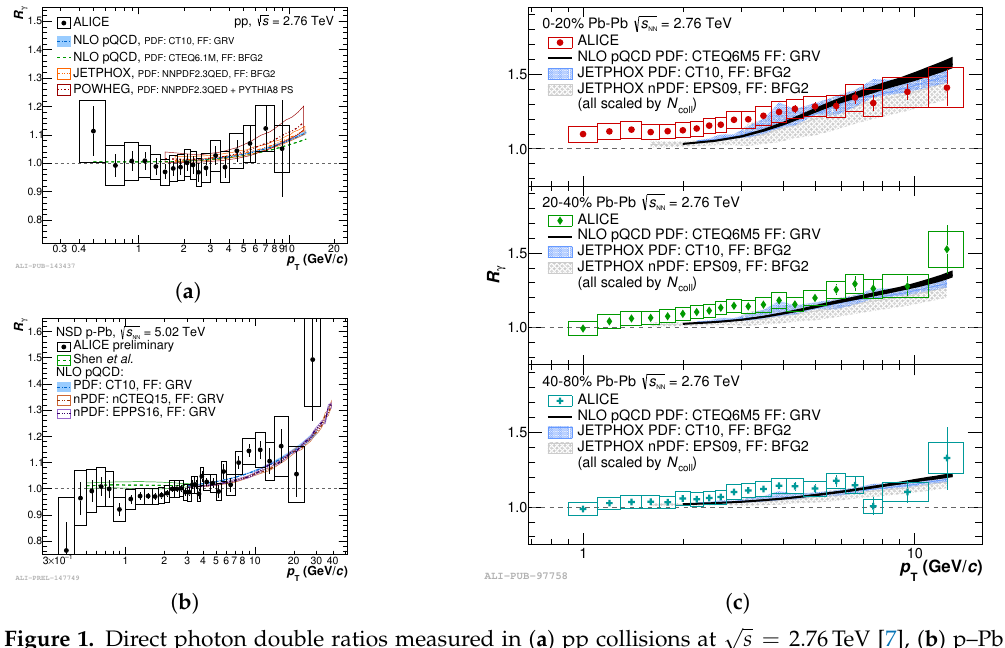
Figure 1. Direct photon double ratios measured in ( a ) pp collisions at √ s NN = 5.02TeV and ( c ) Pb–Pb collisions at collisions at with theory including pQCD at NLO and hydrodynamic calculations (see [6,7] for